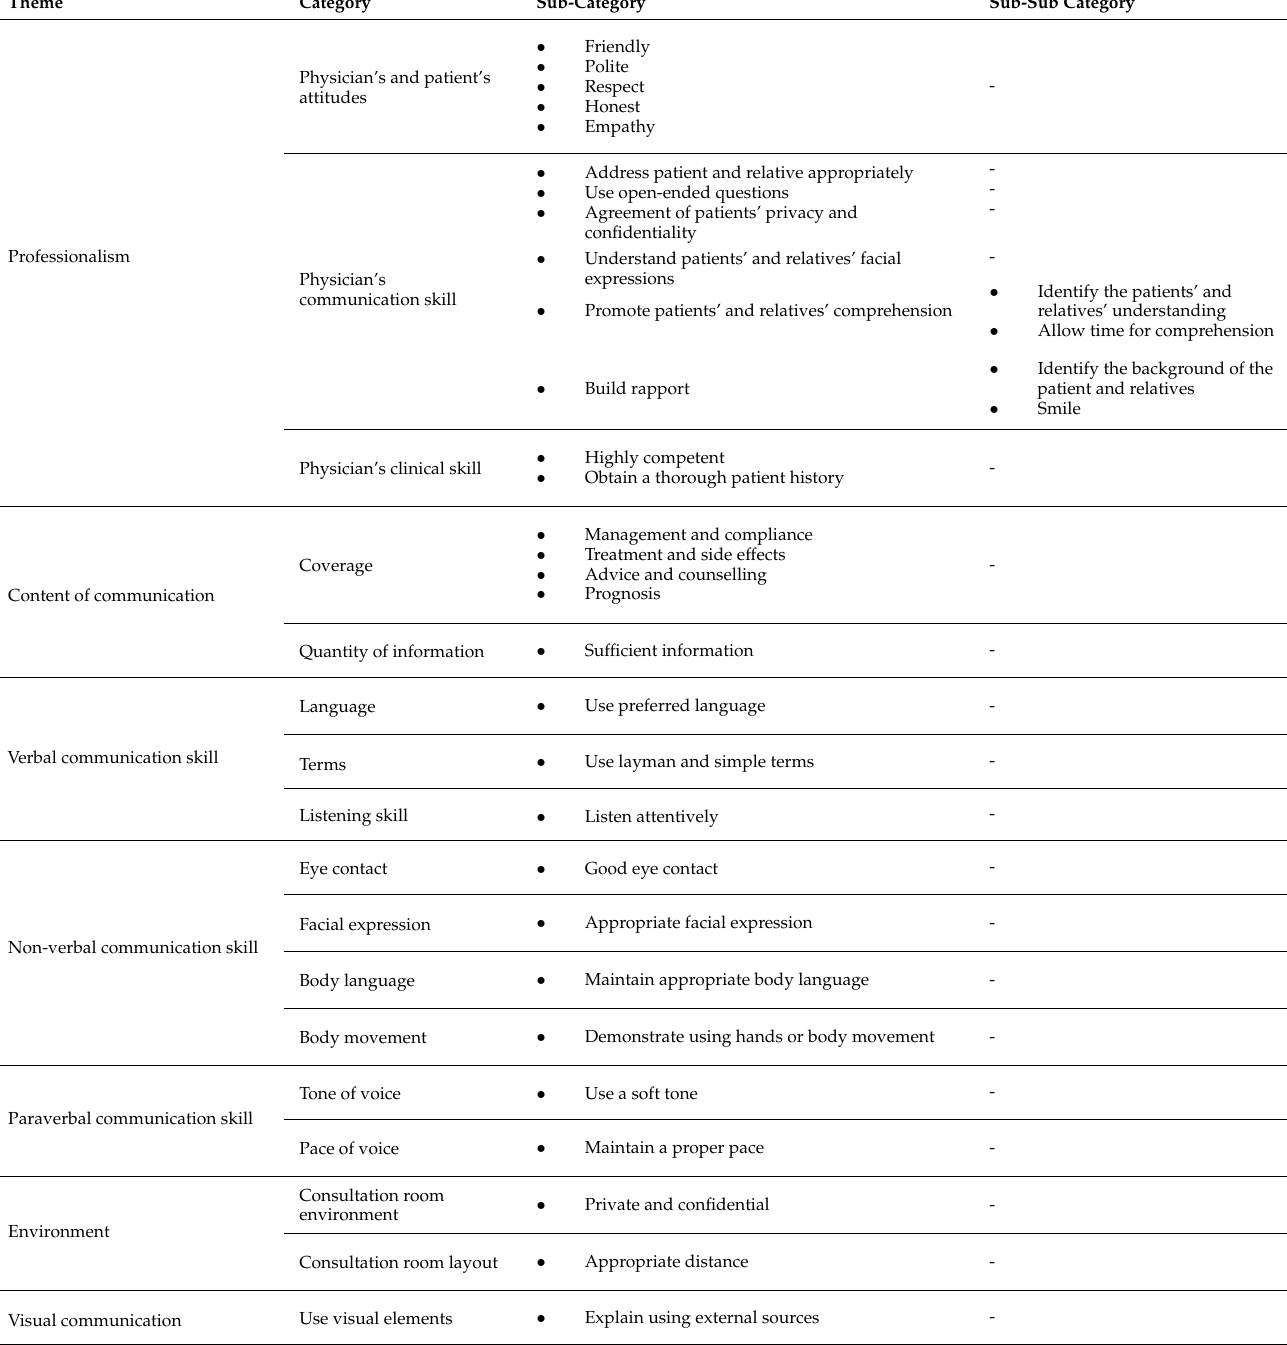
Table 2. Critical components of communication in physician-patient